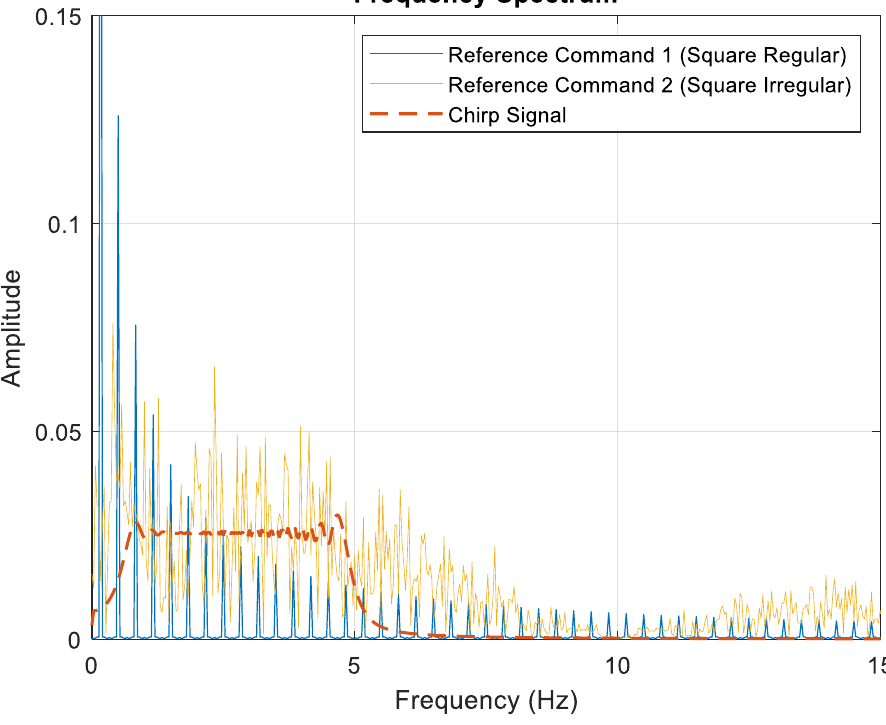
Figure 4. Frequency spectrum of reference commands.